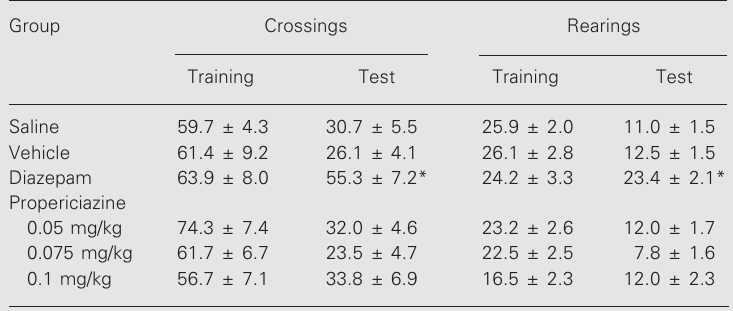
Table 2. Effect of pretreatment with propericiazine on habituation to an open-field. Group